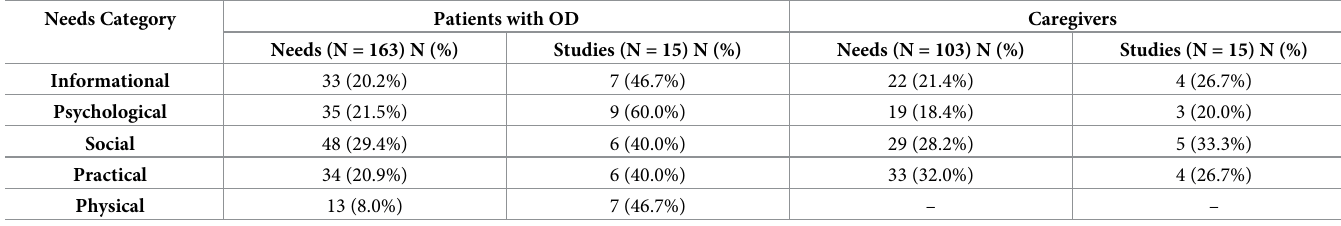
Table 2. Patients’ and caregivers’ needs